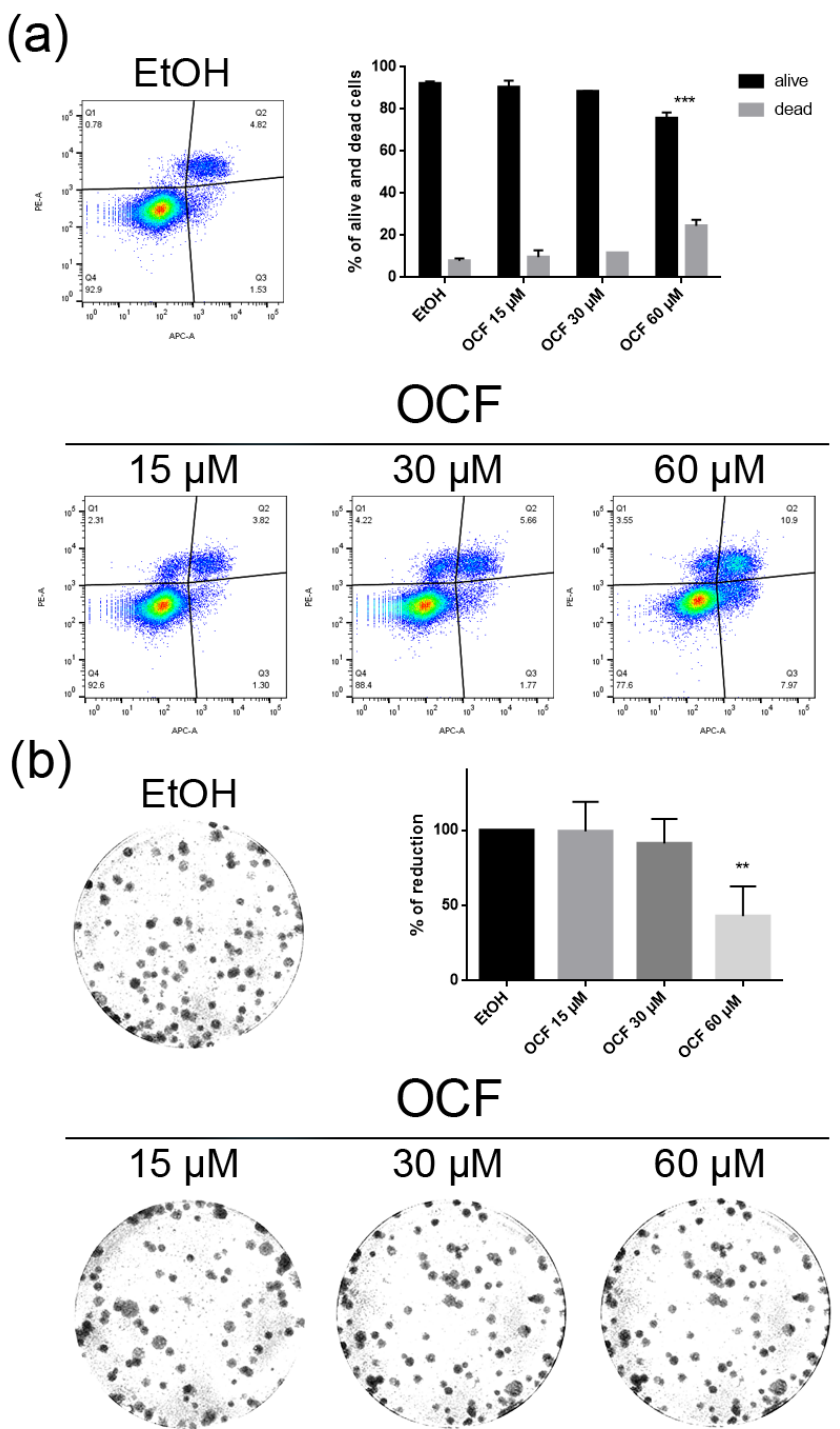
Figure 5. Vitality and colony formation assay of the OCF-treated 5FUr cells. 5FUr cells were treated for 72 h with vehicle or with different doses of the OCF; plots and corresponding histograms for live/dead cells percentages obtained by an annexin V/PI double staining are shown ( a ). Cell colonies obtained after 72 h of the vehicle/OCF treatment and the corresponding percentage quantification ( b ). Data are presented as mean ± SD of three independent experiments. Results of the representative experiments are shown. ** p < 0.01, *** p < 0.001. ( a ) Two-way ANOVA Tukey’s multiple comparisons test; ( b ) One-way ANOVA Dunnett’s multiple comparisons